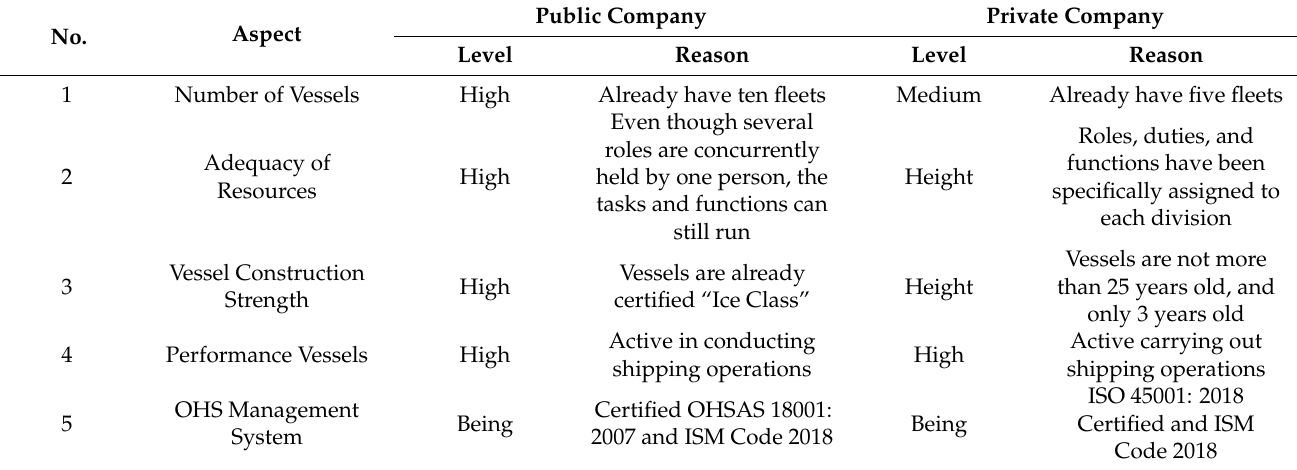
Table 2. The reliability aspects assessment in the public and private companies.